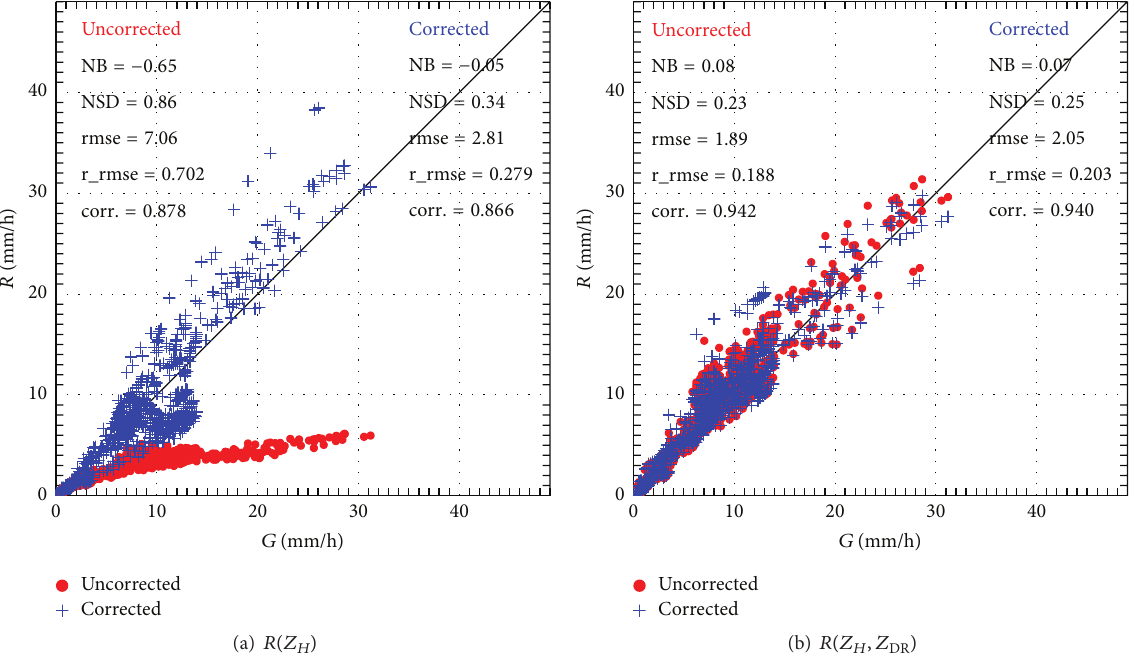
Figure 18: The scatter plots of 𝑅(0.38 km 2 ,60 min ) versus 𝐺(0.07 m 2 ,60 min ) (a) using 𝑍 𝐻 and (b) using 𝑍 𝐻 and 𝑍